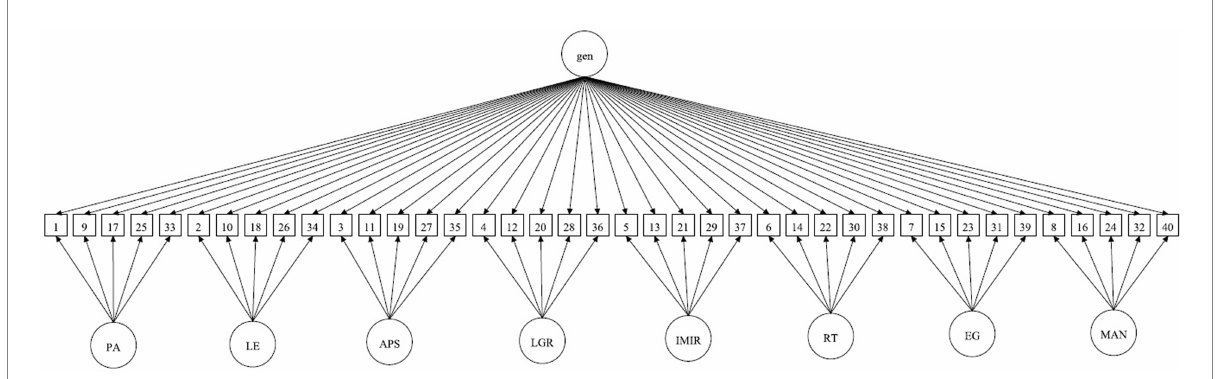
FIGURE 1 Bi-factor model of the Antisocial Beliefs Scale. PA, physical aggression; LE, lack of empathy; APS, absence of prosocial standards; LGR, lack of guilt or remorse; IMIR, incapacity for mutually intimate relationships; RT, risk taking; EG, egocentrism; MAN,